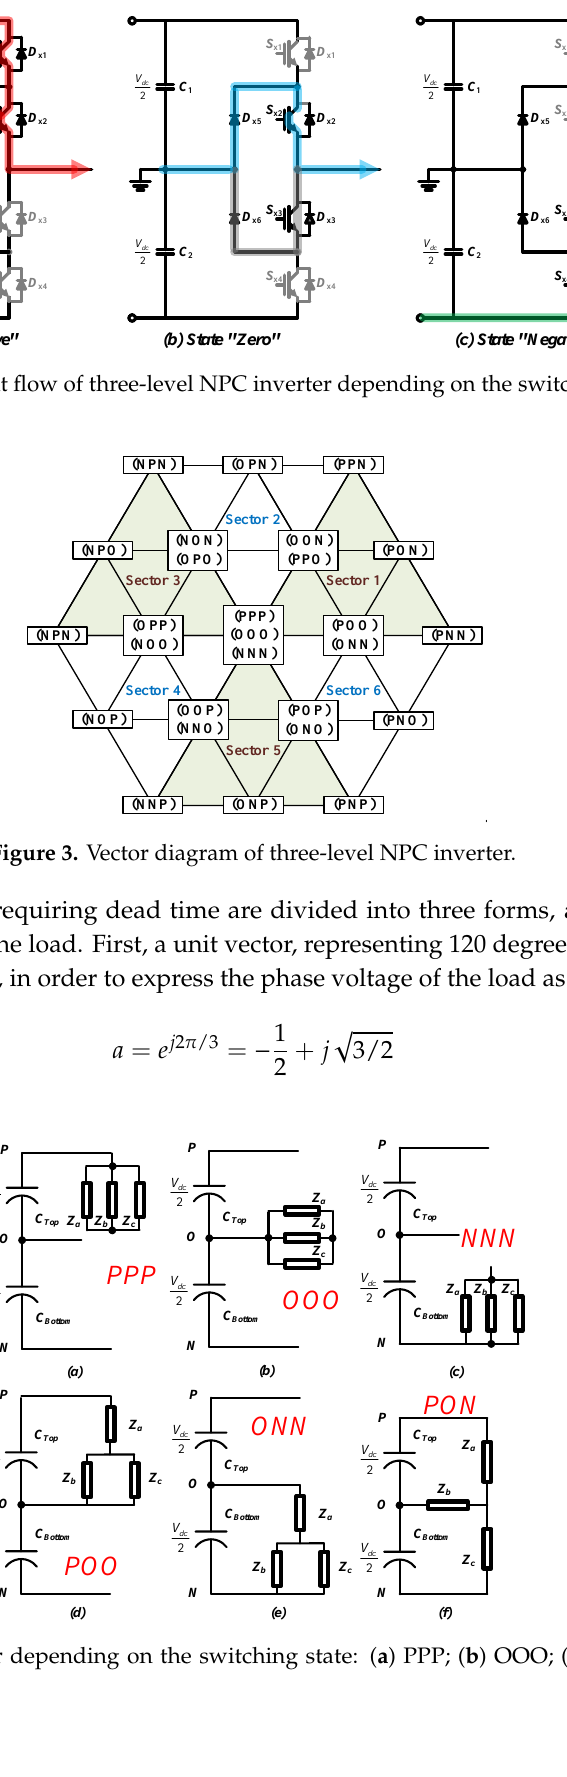
Table 1. Switching state of three-level NPC inverter depending on output voltage.